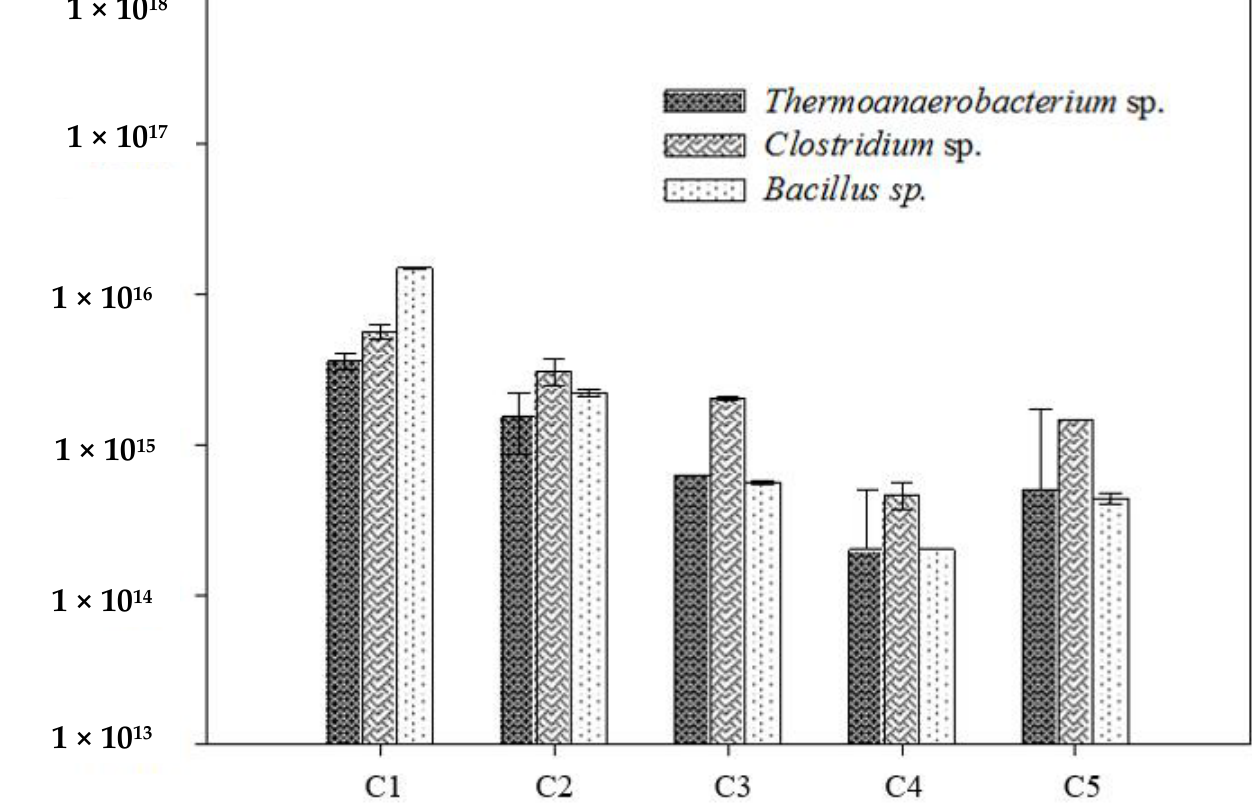
Figure 5. The 16S rRNA amplicons of Clostridium sp., Thermoanaerobacterium sp., and Bacillus sp. in each repeated repetitive sub-culture.